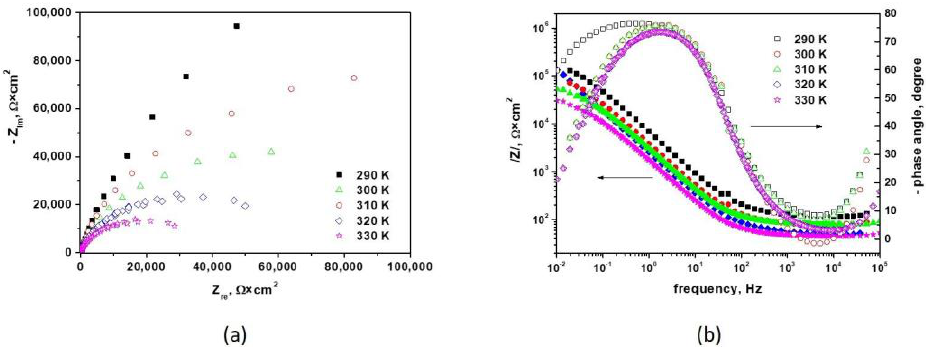
Figure 3. Nyquist ( a ) and Bode ( b ) diagrams for NiCr alloy immersed in artificial saliva at different temperatures.